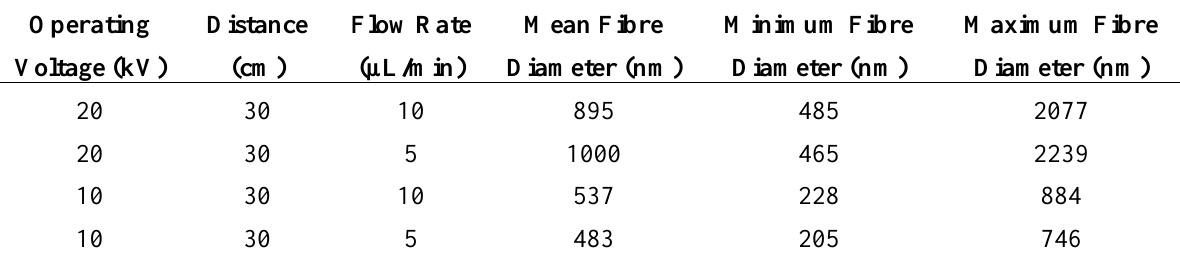
Table 2. The effect of manipulation of spinning parameters on fibre diameter